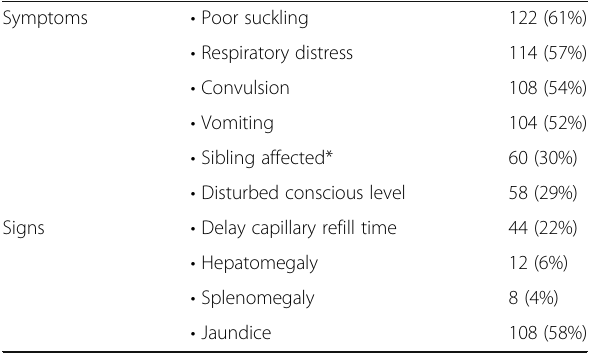
Table 2 Frequency of the most common manifestation among cases